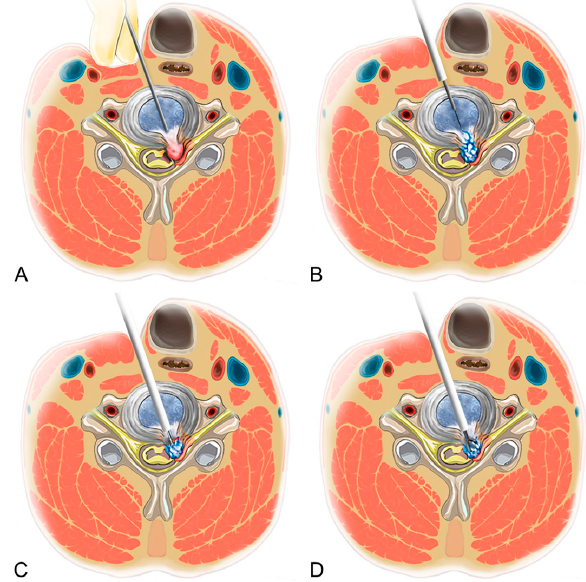
Figure 1. Basic principle of percutaneous endoscopic cervical discectomy (PECD). A .